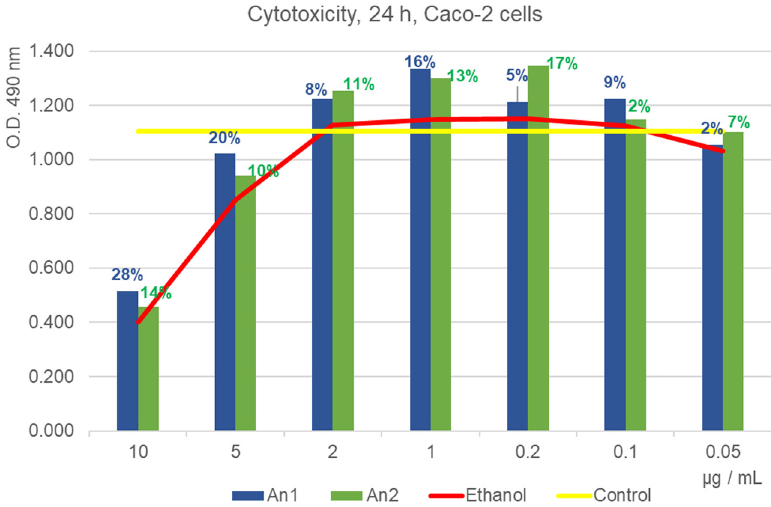
Figure 5: Caco - 2 cell viability response after the treatment with the three - test sample ( An1, An2, and 40% ethanol dilution series ) in comparison with the control negative series, at 24